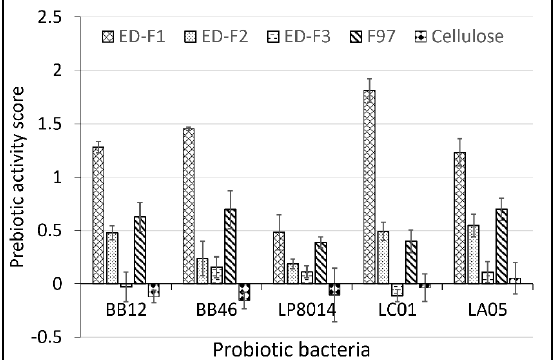
Figure 2. Prebiotic activity score of E. denticulatum fractions obtained through anion exchange chromatography (ED-F1, ED-F2, ED-F3) compared against commercial prebiotic Fibrulose (F97) and a negative control (Cellulose).